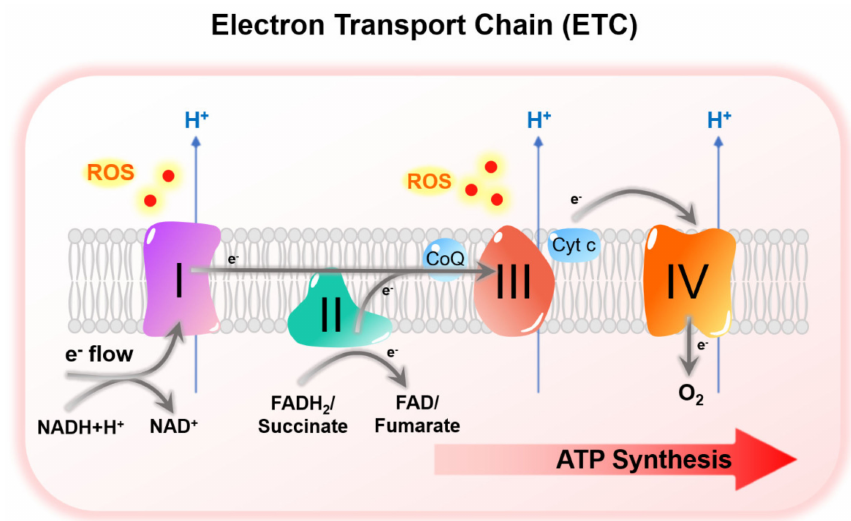
Figure 3. Electron transport chain (ETC). ETC is located at mitochondrial inner membrane (MIM).